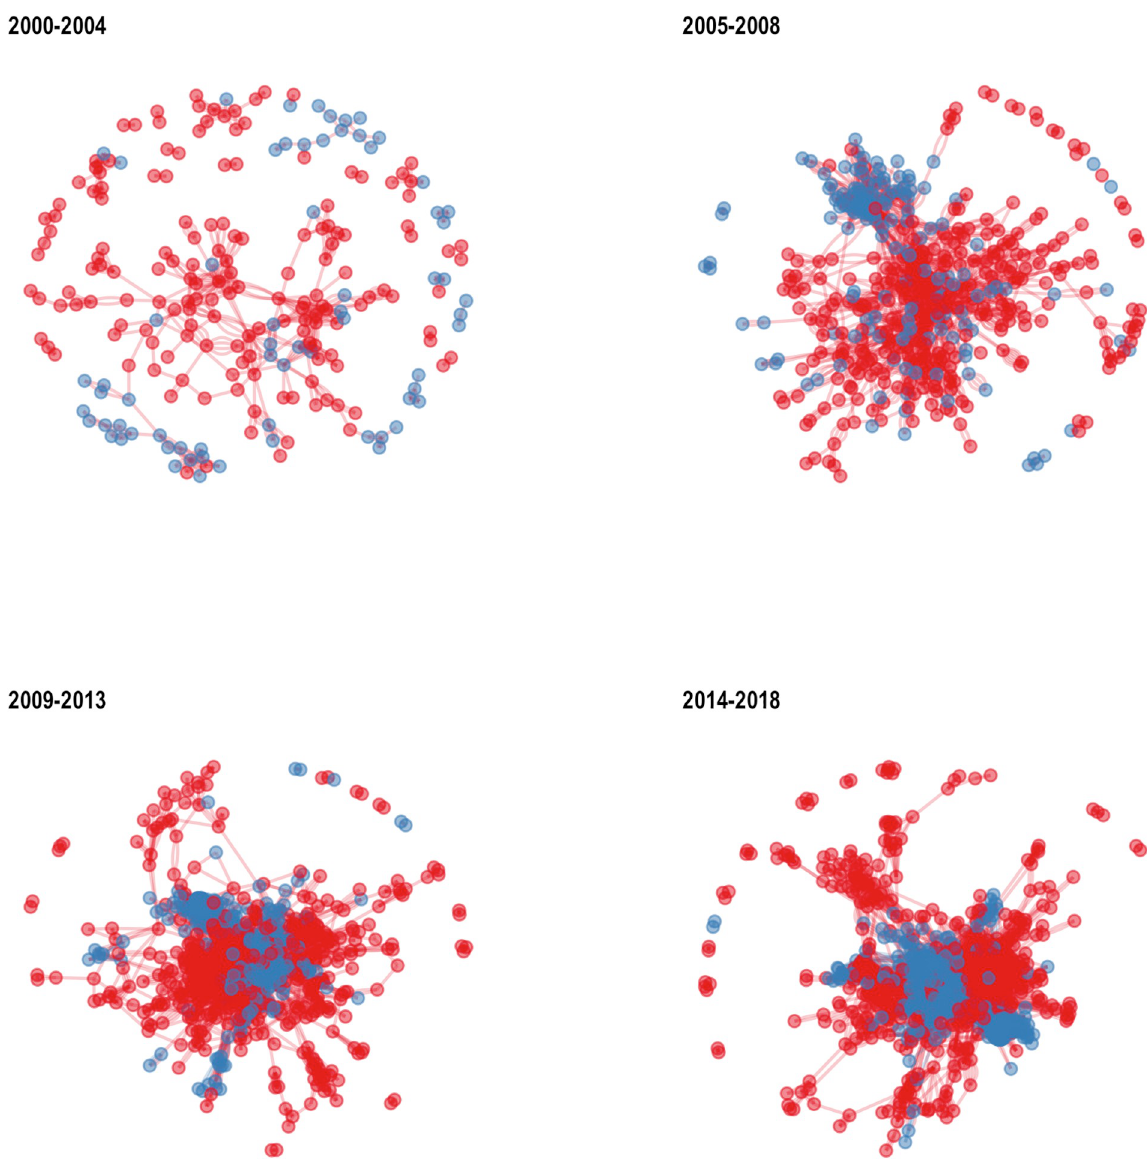
Fig 3. Consolidation of the MoBE collaboration over time. Panels show time slices (non-cumulative) of the giant component of the combined coauthor network. Blue nodes and edges are MoBE authors and papers; red nodes and edges are non-MoBE authors and papers. Network layouts are calculated separate for each slice using the Fruchterman-Reingold algorithm with default values in the igraph package.